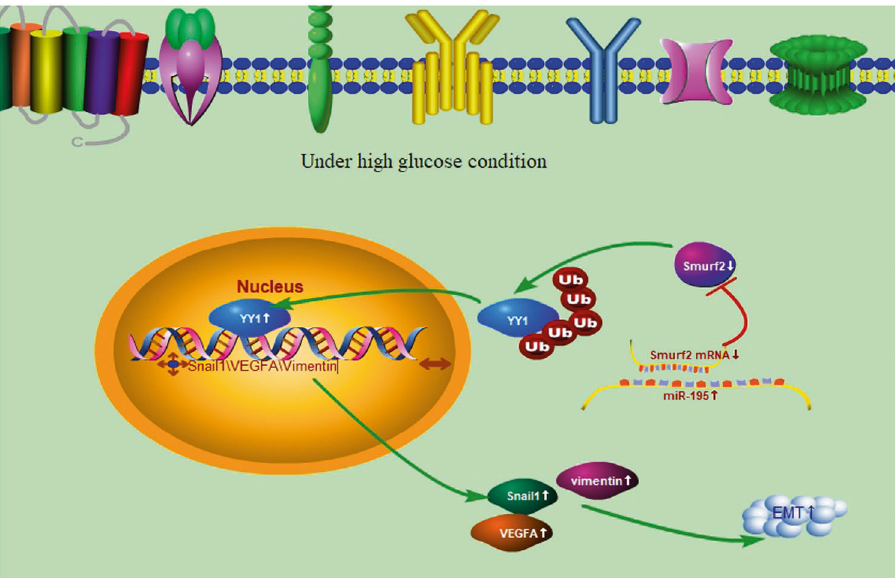
Fig. 7 Proposed model of the role of miR-195 for EMT and permeability in HG-stimulated ARPE-19 cells. miR-195 increased EMT and cell permeability mediated via VEGFA/Snail1 axis in HG-stimulated ARPE-19 cells, possibly via upregulating YY1 indirectly by targeting